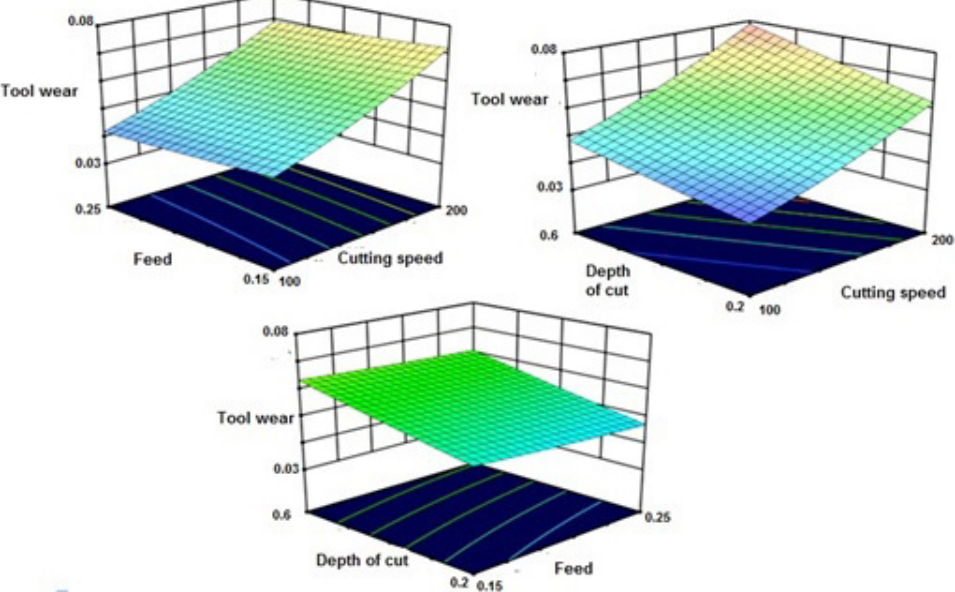
Figure 5. Effect of tool wear with a) cutting speed and feed b) cutting speed and depth of cut c) feed and depth of